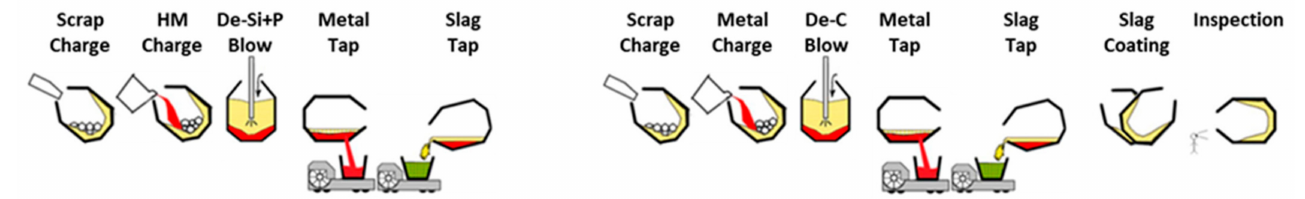
Figure 13. Double slag practice in two separate vessels (2-vessel-double